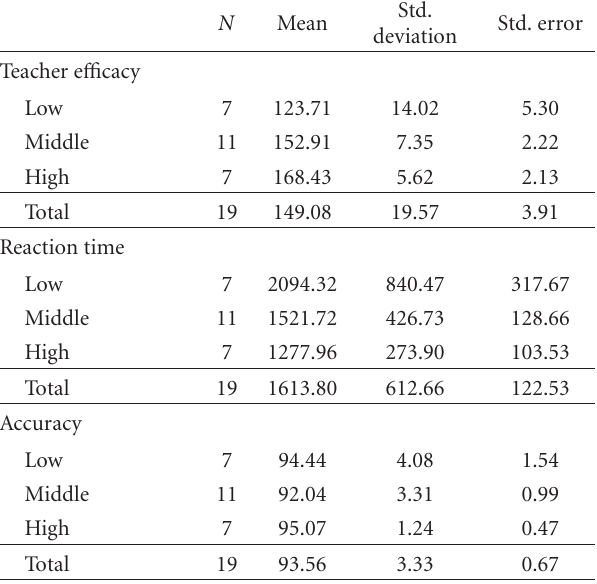
Table 1: The general analysis of teacher e ffi cacy, reaction time, and accuracy.